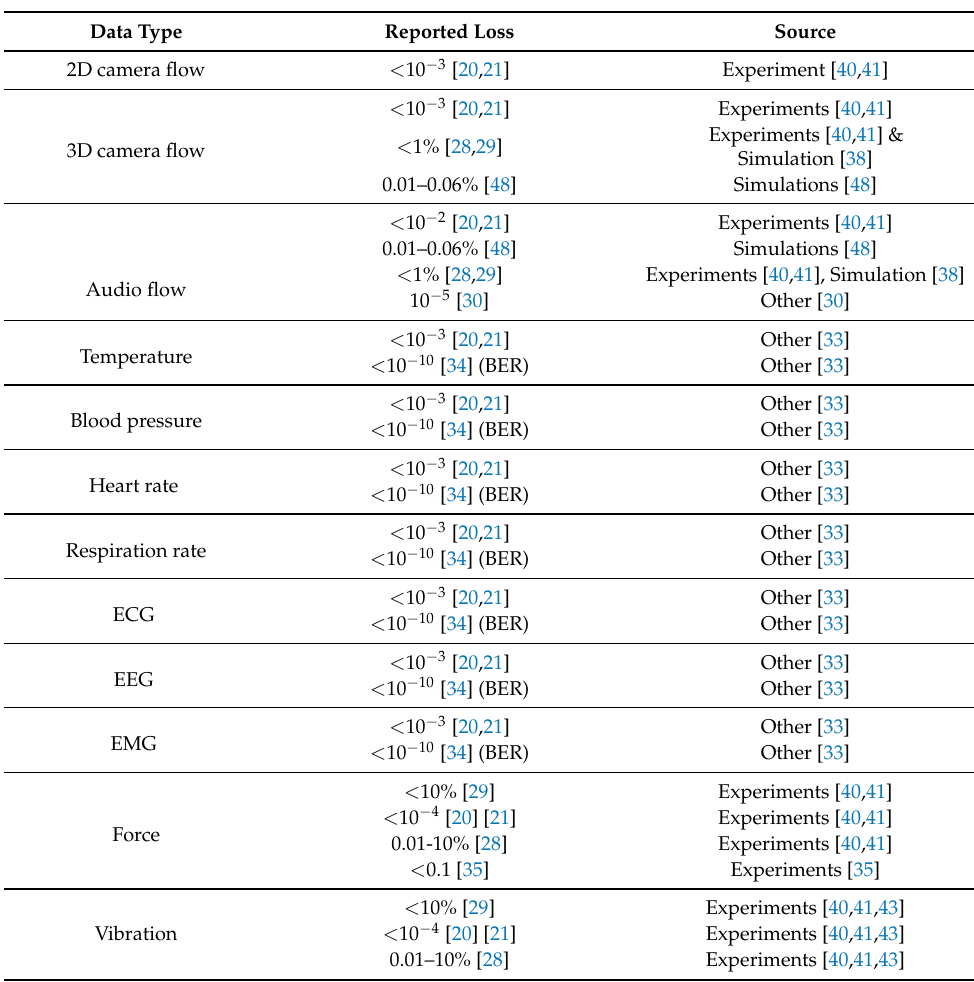
Table A4. Packet loss or bit error rate for telesurgery.